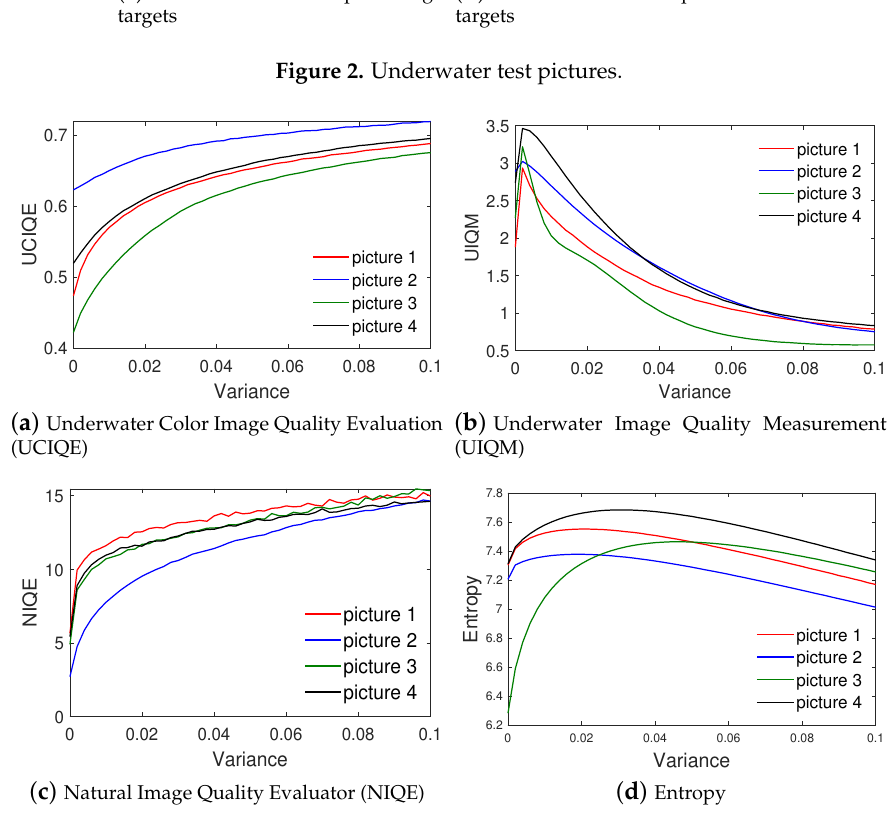
Figure 3. The degree of response of the four indexes to Gaussian